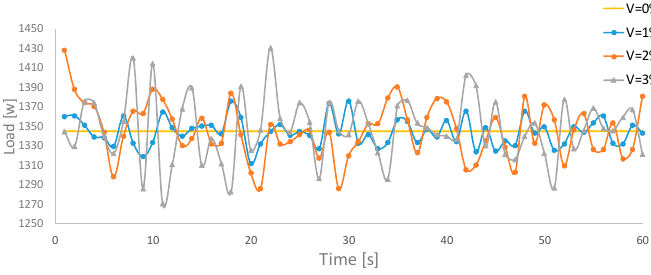
Figure 15. Examples of load fluctuations in one minute at Node(2).